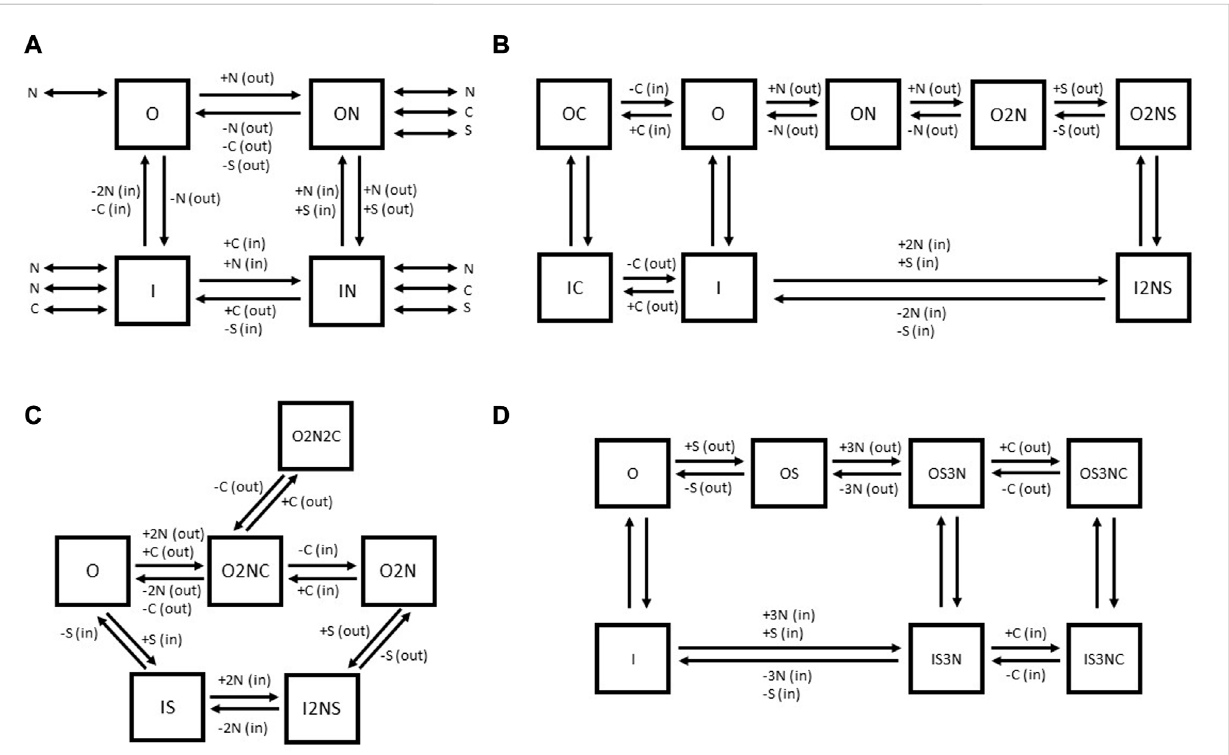
FIGURE 7 Comparison of published kinetic schemes for GAT1 (A – C) and BGT-1 (D) . The outward-facing states of transporters are indicated by the letter “ O, ” while the inward-facing states are indicated by the letter “ I. ” “ N ” indicates Na + , “ C ” indicates Cl − and “ S ” indicates the substrate GABA (for both GAT1 and BGT-1) or betaine (for BGT-1). In parenthesis, (out) or (in) indicates the extracellular or intracellular localization of the respective substrate. For the schemes (B – D) , the (+) and ( − ) signs alongside the substrates near the individual reaction arrows indicate the binding (+) or unbinding ( − ) of the respective substrate. The kinetic scheme (A) is adapted for GAT1 from Hilgemann and collaborators (Hilgemann and Lu, 1999), (B) is based on the kinetic schemeforGAT1proposedbyBichoandcollaborators(BichoandGrewer,2005).Thekineticscheme (C) forGAT1wasoriginallyproposed byCherubino et al. (2012). (D) The kinetic scheme for BGT-1 was proposed by Matskevitch et al.